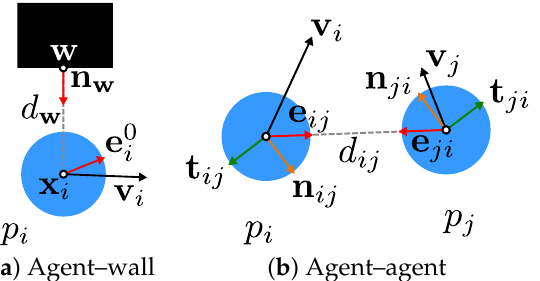
Figure 2. Interactions according to the underlying model of pedestrian dynamics between ( a ) agents (shown as blue points) and obstacles (black rectangle) and ( b ) between two agents, with associ- ated